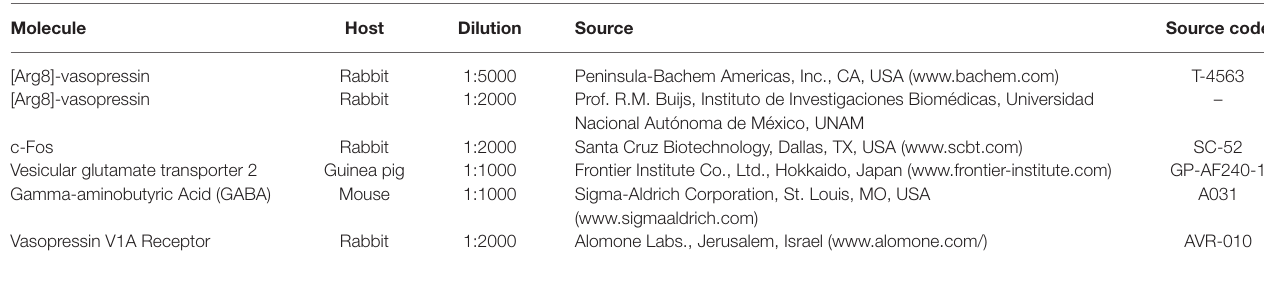
TABLE 1 | Primary antibodies used in this study. Molecule Host